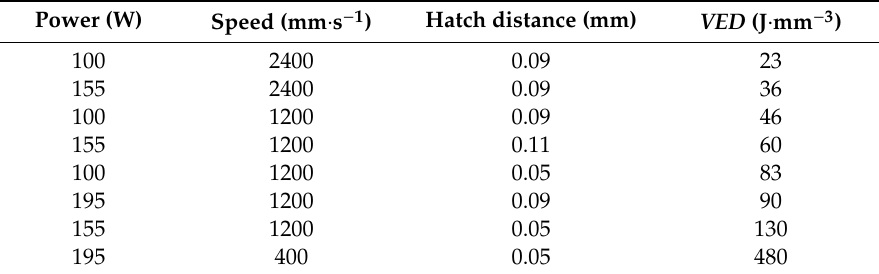
Table 1. Processing conditions of LPBF for given layer thickness of 20 µ m.